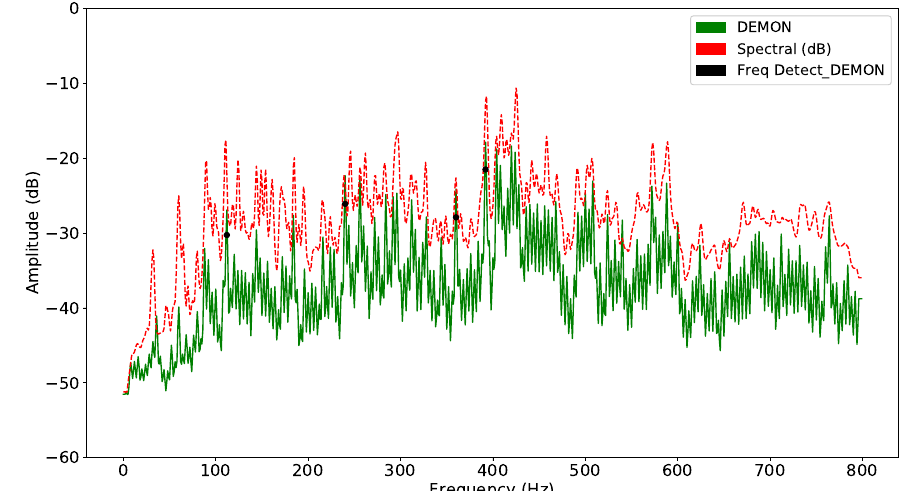
Figure 3. Signal frequency detection by DEMON with Record-1.